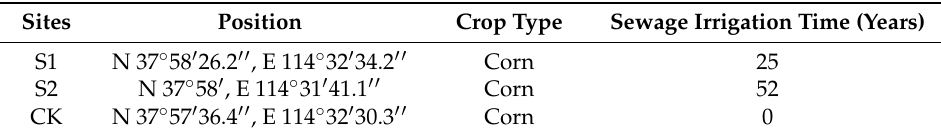
Table 1. Basic situation of soil sampling